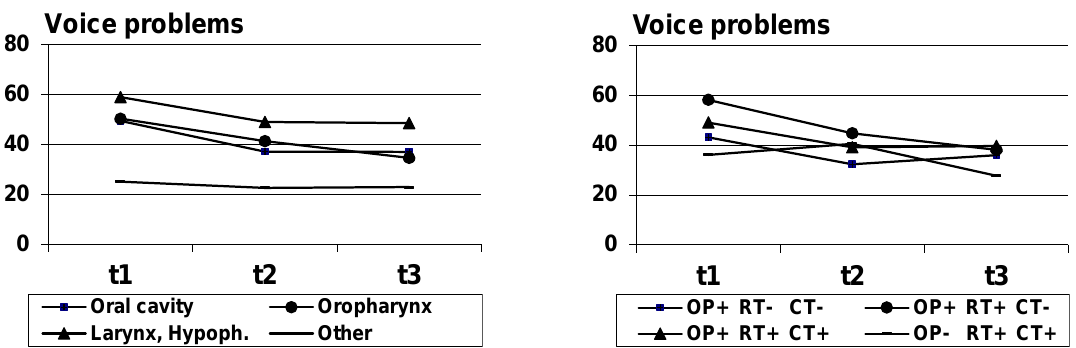
Figure 2. Voice problems mean scores, broken down by diagnosis ( left ) and treatment ( right ); OP+, OP-: surgery yes/no; RT+, RT-: radiotherapy yes/no; CT+, CT-: chemotherapy yes/no.